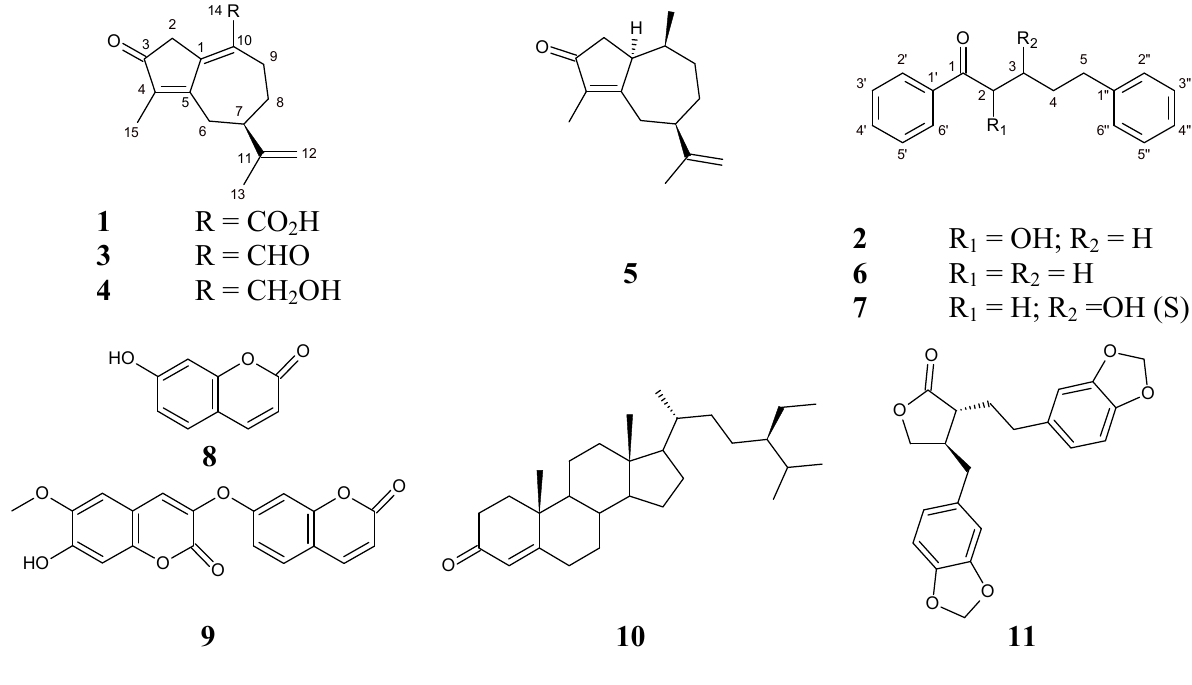
Figure 1. Chemical structures of compounds 1 – 11